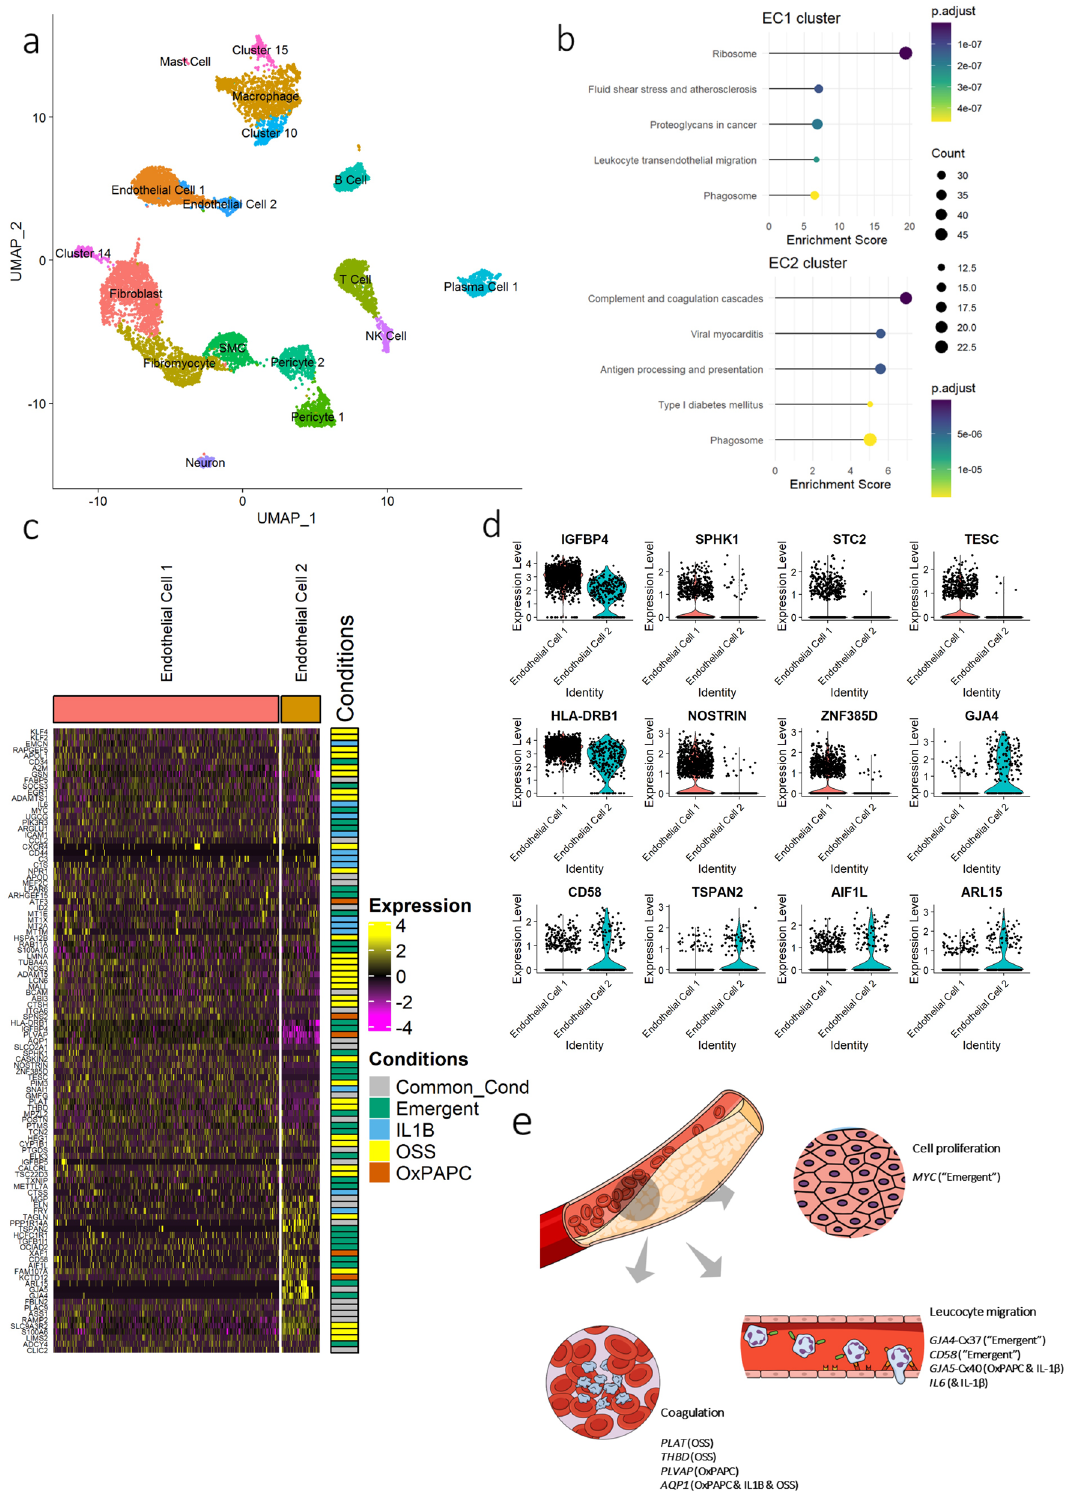
Figure 5. scRNA-seq of human coronary artery atherosclerotic plaque identified two endothelial cells (EC) clusters which are defined by the clustered risk factors DEGs. ( a ) UMAP visualization of clustering identified 17 cell populations (n = 10,671 cells). ( b ) KEGG enrichment analysis of the two EC clusters using the cluster marker differentially expressed genes between a cluster and all remaining cells. DEG were considered for adjusted p -value ≤ 0.05 and |Log2foldchange|≥ 0.25. ( c ) Heatmap of the 103 clustered risk factors DEGs expression levels from each endothelial cell of the two clusters followed by the condition in which they are differentially expressed. ( d ) Violin plot of emergent DEGs which are differentially expressed in EC2 vs. EC1. ( e ) Schematic illustrating the key dysregulated pathway in the clustered risk factors which are recapitulated in human atherosclerotic plaque. ( e ) Created in the Mind the Graph platform (www. mindt hegra ph.